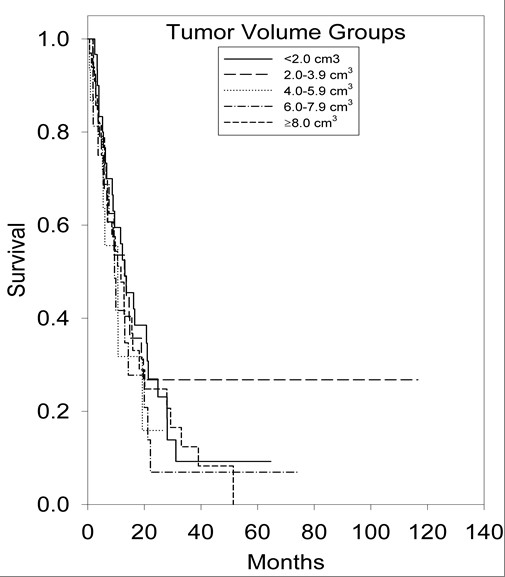
Kaplan-Meier survival curve illustrating overall survival based on volume of brain metastases.